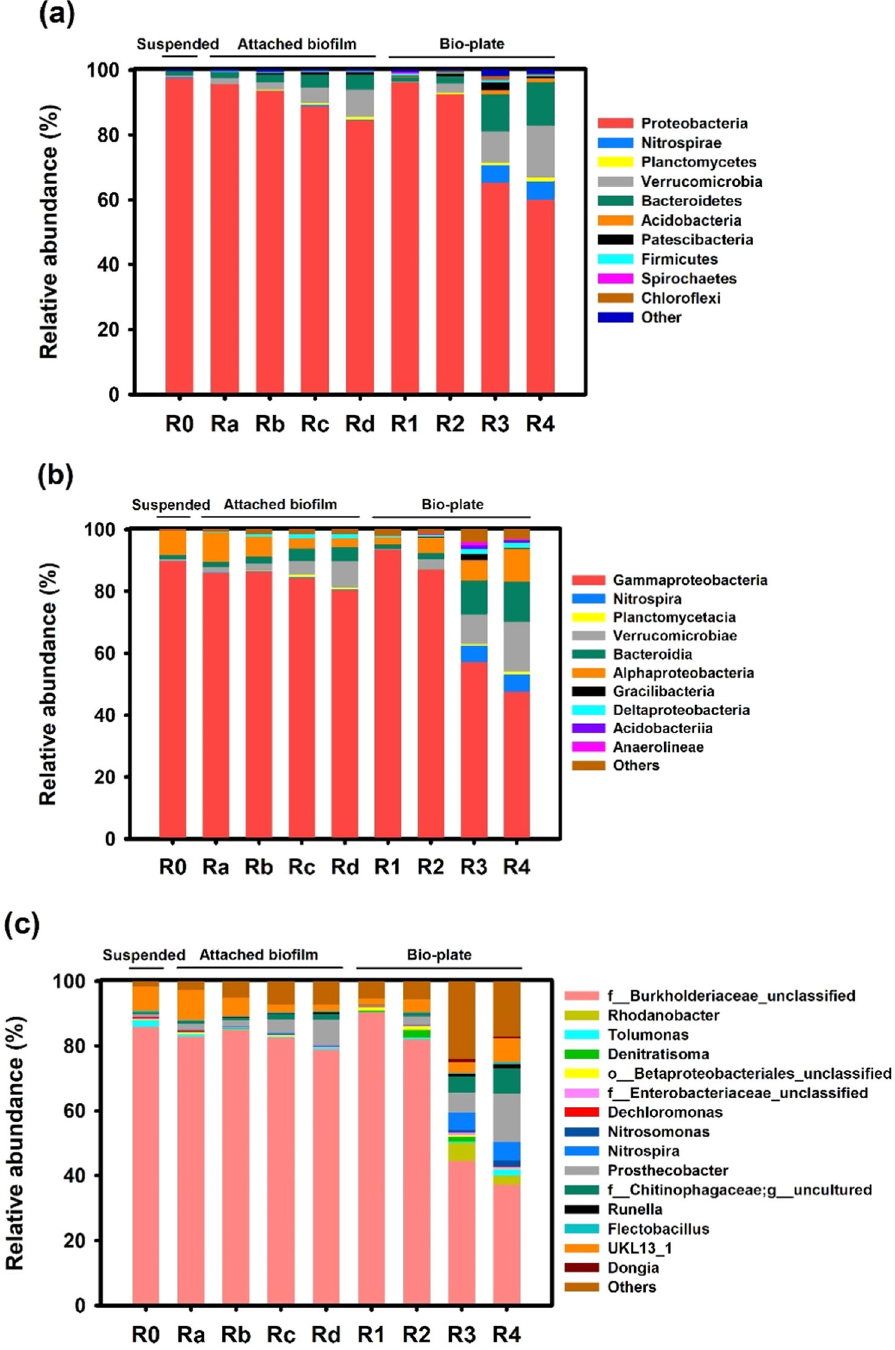
Fig. 5 Microbial communities of the different compartments of IBPR. a Plot at the phylum level; b Plot at the class level, and c genus level. (R0: suspended fl ocs; Ra – Rd: attached bio fi lms on each bioplate; R1 – R4: biomass entrapped in the bioplates, as shown in Fig.